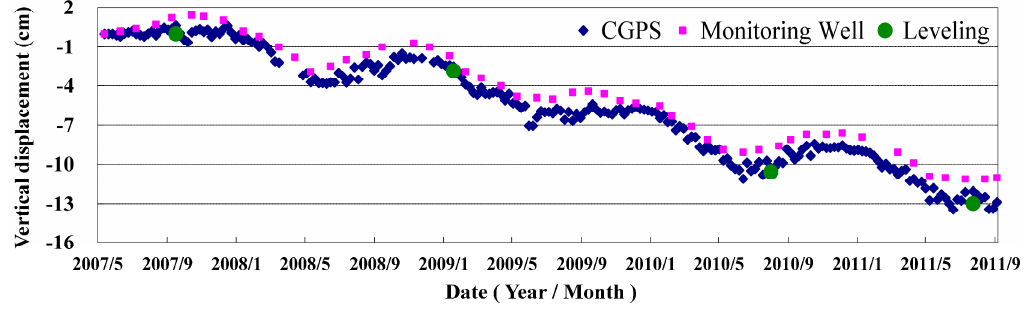
Figure 8. Vertical displacements at BDES from GPS (weekly averages from daily solutions), compaction-monitoring well and precision leveling.